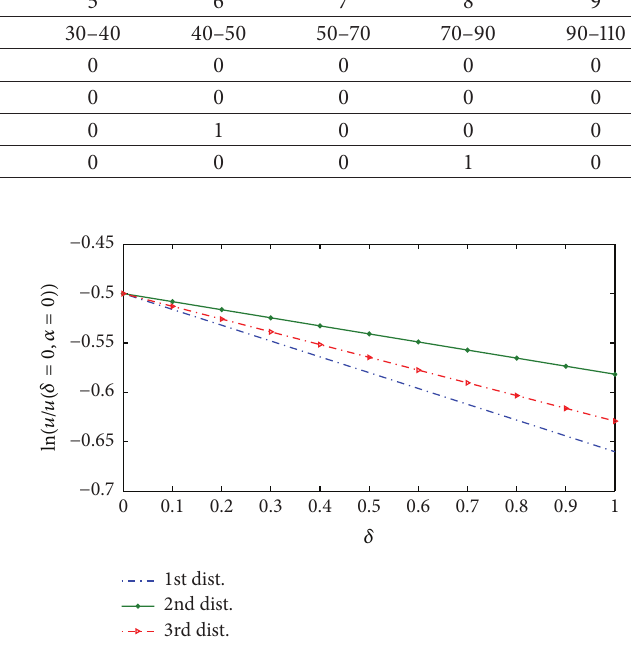
Figure 14: Influence of the initial droplet size distribution in determining the flame velocity of laminar spray flames as function of the initial liquid fuel load, polydisperse spray.